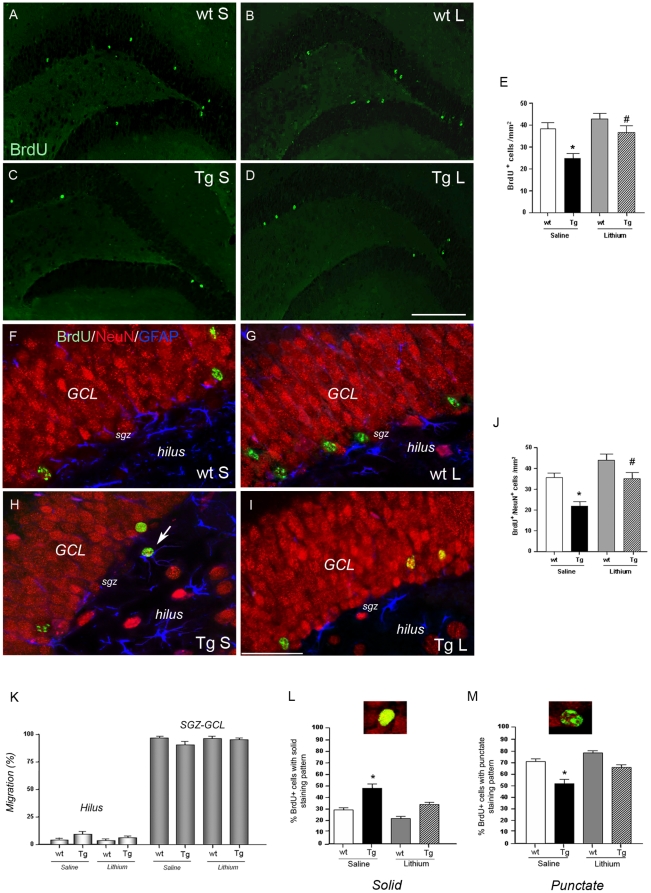
Cell survival in the SGZ-GCL of 3-month-old wt and TgCRND8 mice and effect of lithium treatment.A–D: immunohistochemical detection of BrdU+ cells (green) 5 weeks after the last administration of BrdU in the saline (A) and lithium (B)-treated wt and in the saline (C) and lithium (D)-treated Tg mice. Scale bar = 200 µm (A–D). E: quantification of the BrdU+ cells, *P<0.05, Tg vs wt, saline-treated group; #P<0.01 lithium-treated Tg vs saline-treated Tg mice. F–I: triple labelling immunohistochemistry with BrdU (green), NeuN (red) and GFAP (blue) antibodies demonstrating the co-localization of BrdU and NeuN and their migration into the SGZ-GCL in the saline (F)- and lithium (G)-treated wt and saline (H)- and lithium (I)-treated Tg mice. Arrow in H indicates a newborn cell in the hilus region. Scale bar = 50 µm (F–I); J: quantitative analysis of the number of BrdU+ that was NeuN+ in the SGZ-GCL. A lower number of BrdU+/NeuN+ cells was found in the saline-treated Tg compared to saline-treated wt mice (*P<0.05) and this number recovered to control values following lithium treatment (#P<0.01, lithium-treated Tg vs saline-treated Tg mice). K: quantitative analysis of the number of newly-born neuron migrated into SGZ-GCL and hilus regions. L: quantitative analysis of the number of newborn cells with a solid BrdU appearance and a representative photomicrograph showing a cell with a solid staining pattern. *P<0.05, saline-treated Tg vs wt groups and vs lithium-treated Tg mice. M: quantitative analysis of the number of newborn cells with a punctate BrdU appearance and a representative photomicrograph showing a cell with a punctate staining pattern. *P<0.05, saline-treated Tg vs wt groups and vs lithium-treated Tg mice. One-way ANOVA plus Bonferroni's post-comparison test. wt: wild type, Tg: TgCRND8, S = saline, L = lithium.